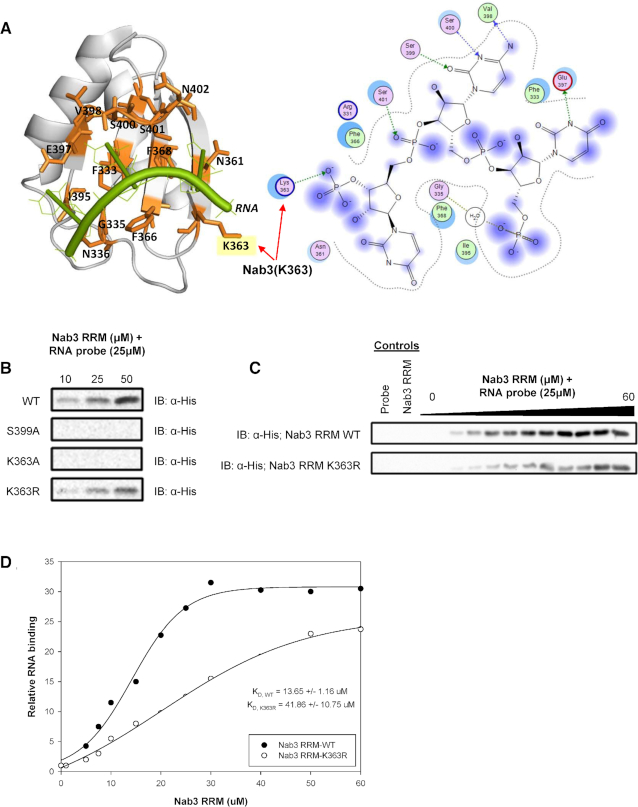
The Nab3 lysine-363 to arginine mutation attenuates RNA binding in vitro. (A) Co-crystal structure of Nab3 demonstrating the proximity (left) and interaction (right) of the K363 methylation site with bound RNA (PDB 2XNQ). Structures were visualized using PyMol (left) and Molecular Operating Environment (right). (B) Effect of single mutants (S399A, K363A, K363R) on RNA binding activity of Nab3 RRM (329–419) protein to 25 μM snR47 RNA probe (UUUCUUUUUUCUUAUUCUUAUU). Immunoblot detection by terminal 6xHis tag present on all Nab3 constructs. (C) Dose-response (0–60μM) of Nab3 RRM (329–419) and Nab3 RRM (329–419; K363R) to 25μM snR47 RNA probe. (D) Quantification of Nab3 RRM binding activity to snR47 probe. All RNA binding was monitored by RNA pull-down assay.